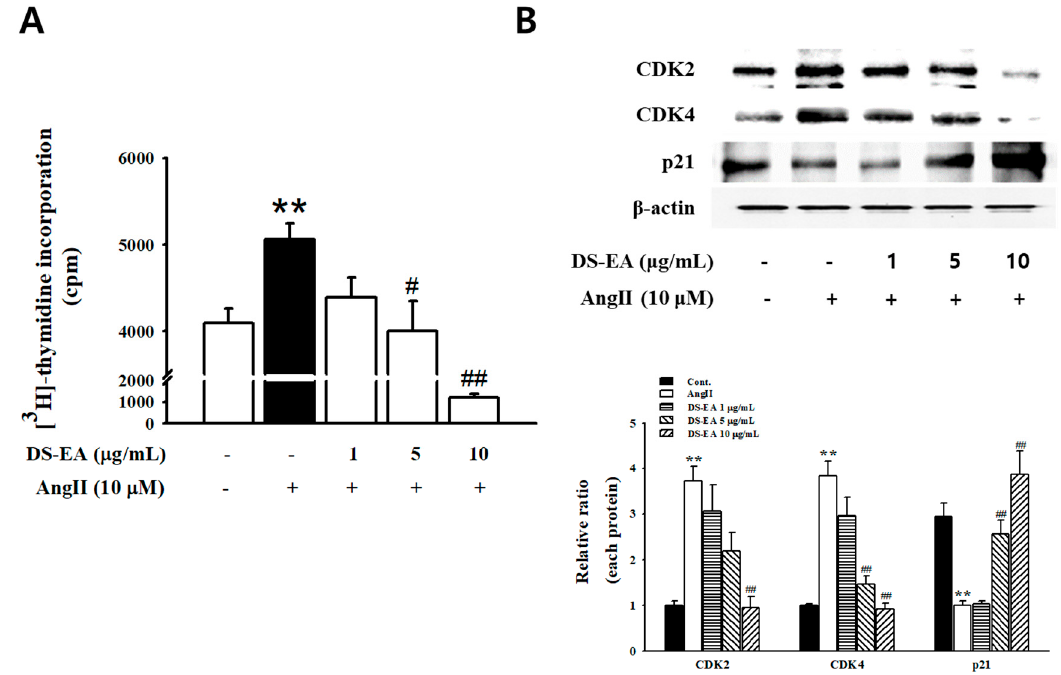
Figure 7. Effect of DS-EA on Angiotensin II (Ang II)-induced human renal mesangial cell proliferation. ( A ) Mesangial cells were seeded into 24-well plates. After confluence, the cells incubated for 48 h with or without Ang II and various concentrations of DS-EA (1–10 µ g/mL) and were then pulse-labeled with [3H]-thymidine for 24 h. ( B ) Western blot analysis was performed with antibodies specific for CDK2, CDK4, and p21waf1/cip1. Results are expressed as the mean ± S.E. from five independent experiments. ** p < 0.01 vs. control; # p < 0.05, ## p < 0.01 vs. Ang II alone.